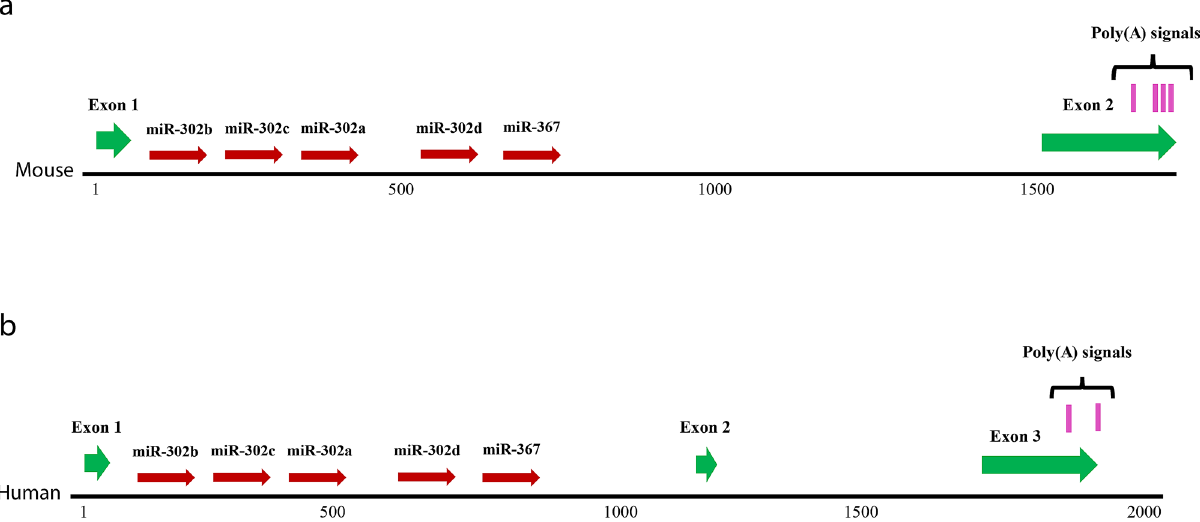
Figure 1. Comparison of murine ( a ) and human ( b ) miR-302 host-gene structures (LOC110008574 (Gm51018) and LOC109864269 respectively). The genomic coordinates for the mmu-miR-302 host-gene and the hsa-miR-302 host-gene are located at chr3:127,545,089–127,546,901 plus strand (GRCm38/mm10) and chr4:112,646,720–112,648,703 minus strand (GRCh38/hg38) respectively. The murine gene lacks the central exon but has four potential poly adenylation signals. Note the different